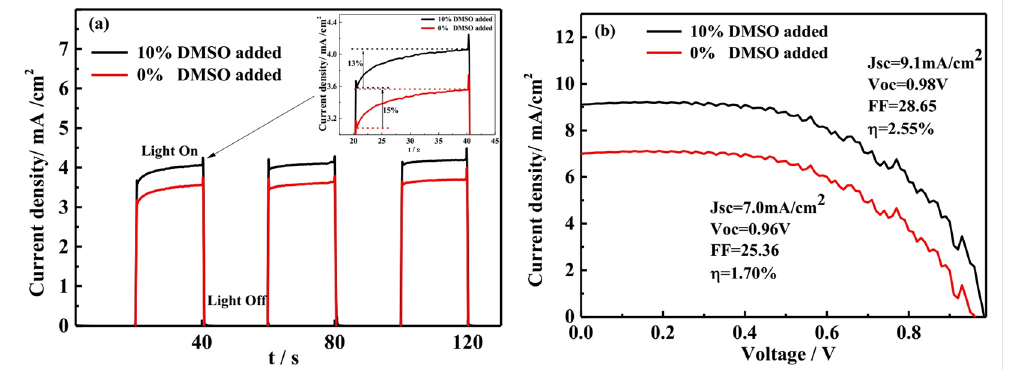
Figure 9. ( a ) The transient photocurrent-time; ( b ) The J-V curves of the perovskite solar